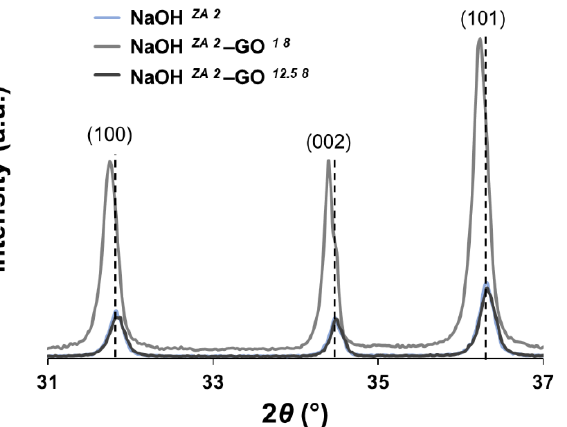
Figure 3. XRD diffractograms of ZnO (NaOH ZA 2 ) and ZnO–rGO structures (NaOH ZA 2 –GO 1 8 and NaOH ZA 2 –GO 12.5 8 ) in the 2 θ range from 31 to 37 ◦ . Table 3. The FWHM value and lattice parameters of (101) plane present in the XRD diffractograms of ZnO and ZnO–rGO structures. The BET value of the samples is also represented. Lattice Parameters FWHM FWHM